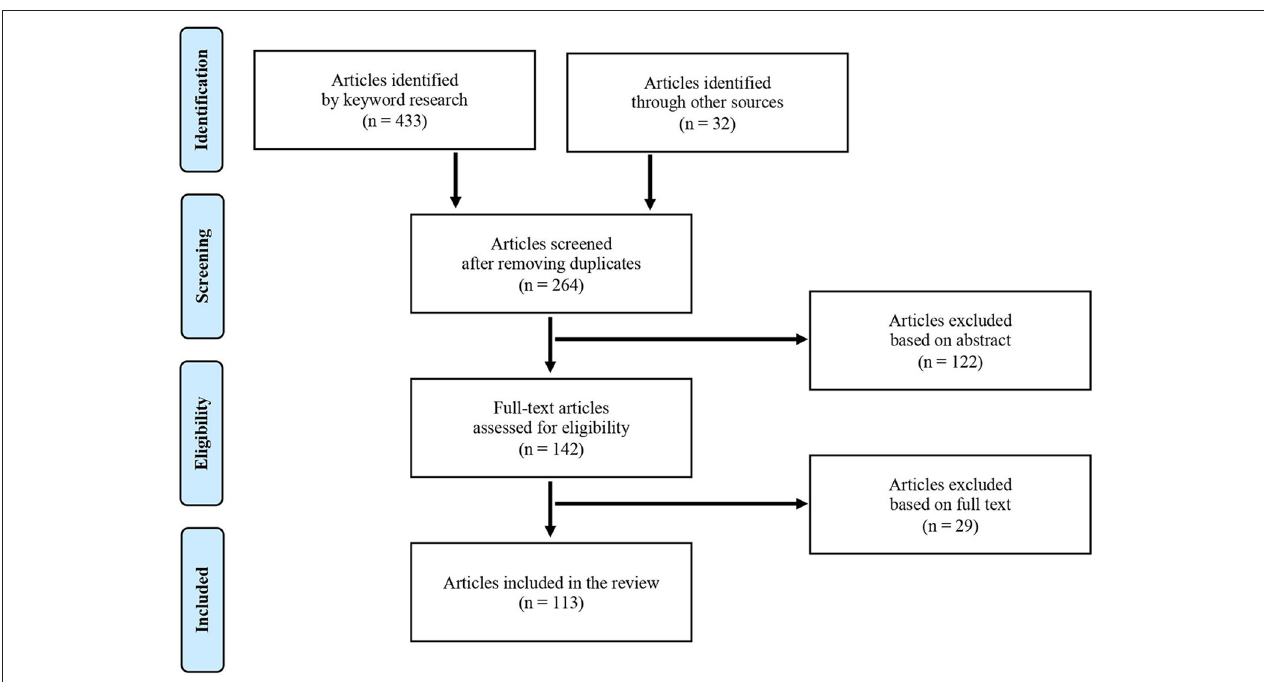
FIGURE 3 | PRISMA flow diagram. The diagram indicates the number of articles in each step of the systematic review, from the initial identification to the application of the exclusion